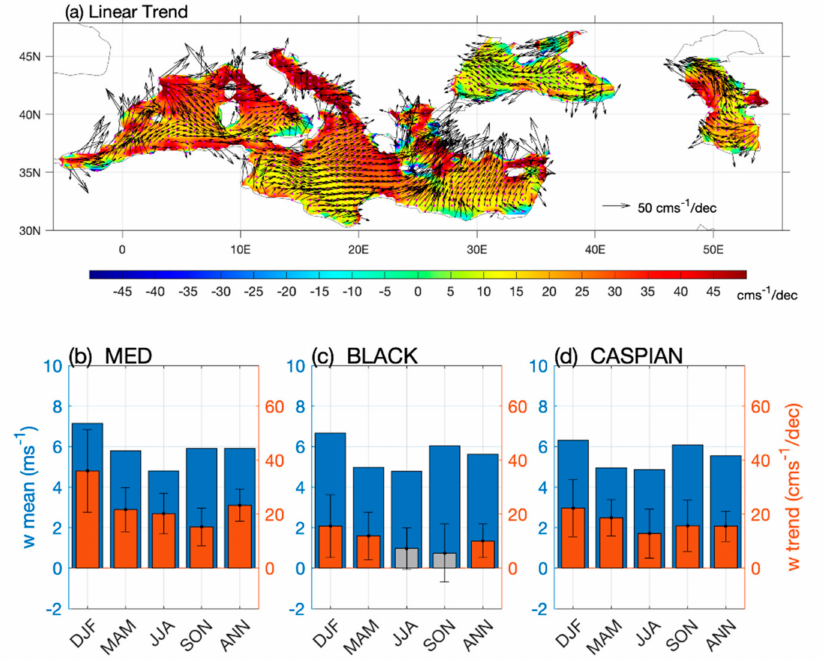
Figure 9. ( a ) Linear trends of annual-mean surface wind speed and vector subsetted from Figure 8a for the South European marginal seas. The magenta dotted areas denote the linear trends of wind speed that are significant at the 90% confidence interval. ( b – d ) Bar plots of the basin-averaged mean values (blue bars, left y -axis) and linear trends (red and gray bars, right axis) of wind speed in four seasons: December-January-February (DJF), March-April-May (MAM), June-July-August (JJA), and September-October-November (SON) and the total annual mean (ANN) for ( b ) the Mediterranean Sea (MED), ( c ) the Black Sea (BLACK), and ( d ) the Caspian Sea (CASPIAN). Error bars denote the upper and lower limits of the 90% confidence intervals. Linear trends that are statistically significant (not significant) are colored by red